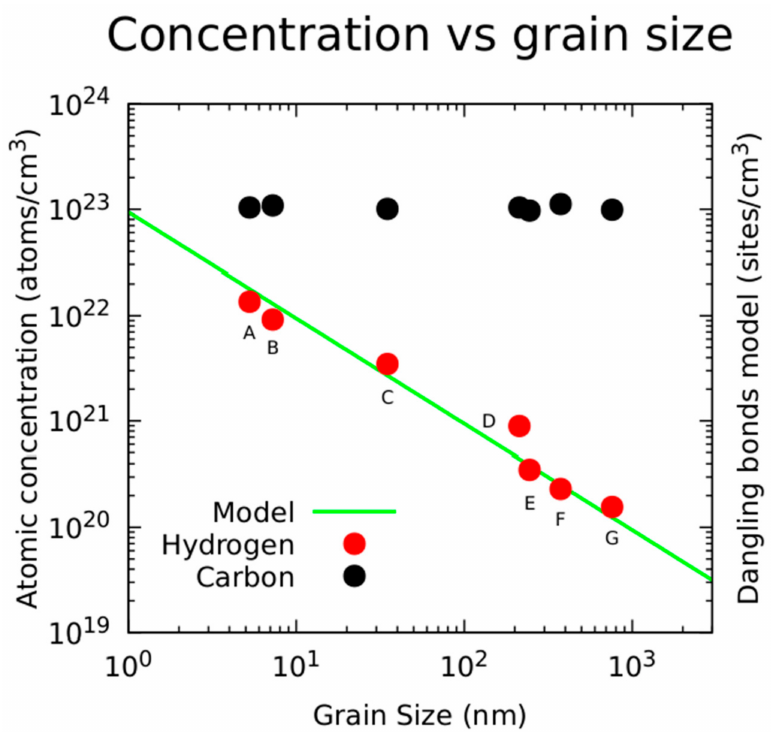
Figure 5. C and H atom concentration [H] vs. PCD film grain size, and number of dangling bonds per site. [H] data are extracted from Sims measurements. The solid line indicates the calculated density of dangling bonds assuming 2 C atom dangling bonds per unit cell per bulk sample